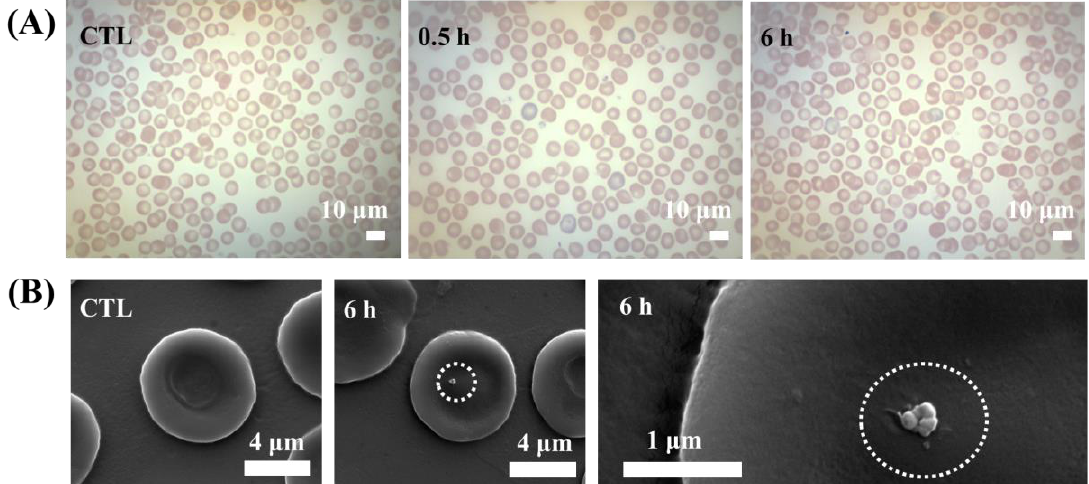
Figure 6. ( A ) Optical microscopy images and ( B ) SEM images of red blood cells gathered from a Balb/c mouse after injection of MTX-LDH suspension (CTL: negative control). The MTX-LDH suspension (10 mg/mL) was injected (100 μL) through the tail vein, and the blood was analyzed at each time point.